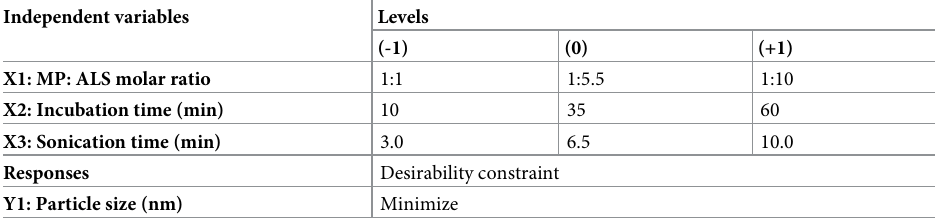
Table 1. Independent variables’ levels and response constraint used in the Box-Behnken design for the optimiza- tion of ALS-MP nanoconjugates. Independent